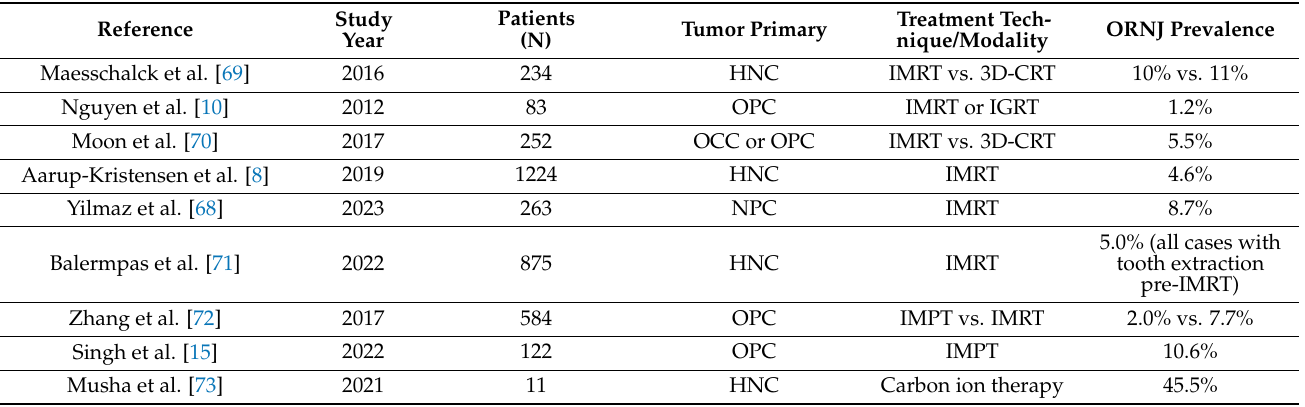
Table 1. Studies investigating the impact of radiotherapy technique and modality on osteoradionecro- sis of the jaws